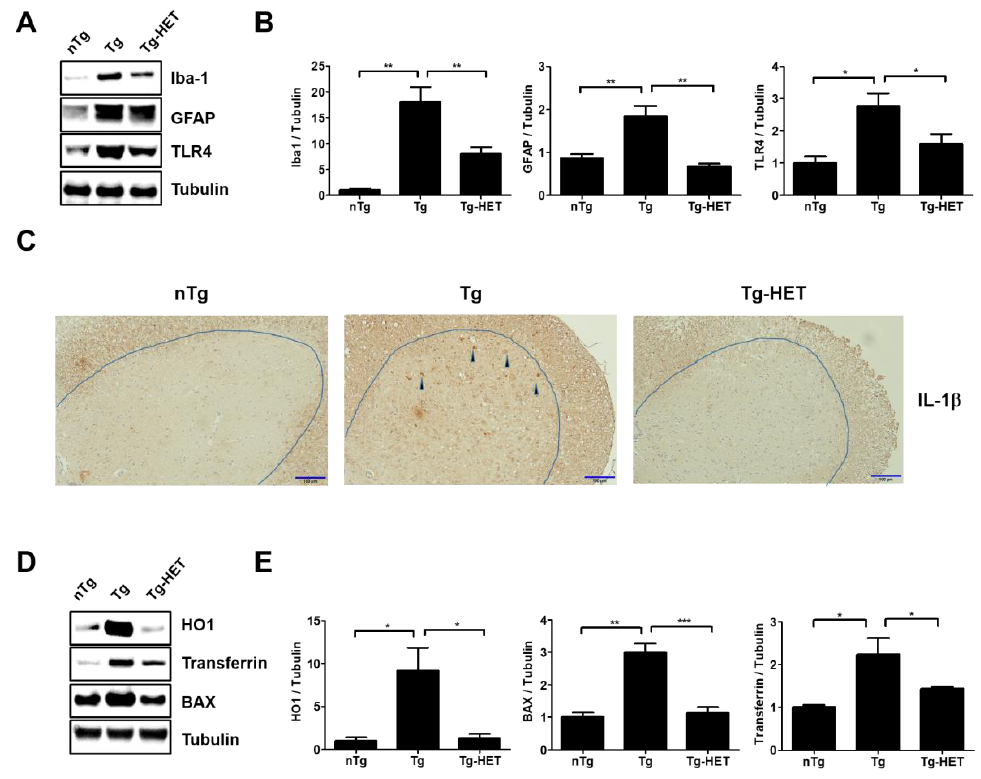
Figure 2. Hochu-ekki-to (HET) increases anti-inflammation and anti-oxidative stress effects in the spinal cord of an ALS mouse model. ( A ) Representative Western blots on inflammatory protein levels of Iba-1 (a marker of microglia), GFAP (a marker of astrocytes), and TLR4 in the spinal cord of each group (nTg, Tg, and Tg- HET). Tubulin was used as a loading control. ( B ) Quantification of the expression level of Iba-1 / Tubulin, GFAP / Tubulin, and TLR4 / Tubulin in each immunoblot. ( C ) Representative images of IL-1 β immunoreatcivity in the anterior horn of the spinal cord in each group. Scale bars = 100 µ m ( D ) Representative images of oxidative stress-related proteins (BAX, HO1, and Transferrin) in the spinal cord of each group mice. ( E ) Quantification of the expression levels of BAX / Tubulin, HO1 / Tubulin, and transferrin / Tubulin. Data are presented as the mean ± SEM ( n = 3 / group). * p < 0.05, ** p < 0.01, *** p < 0.001. nTg: non-transgenic mice, Tg: hSOD1 G93A , Tg-HET:HET-treated hSOD1 G93A